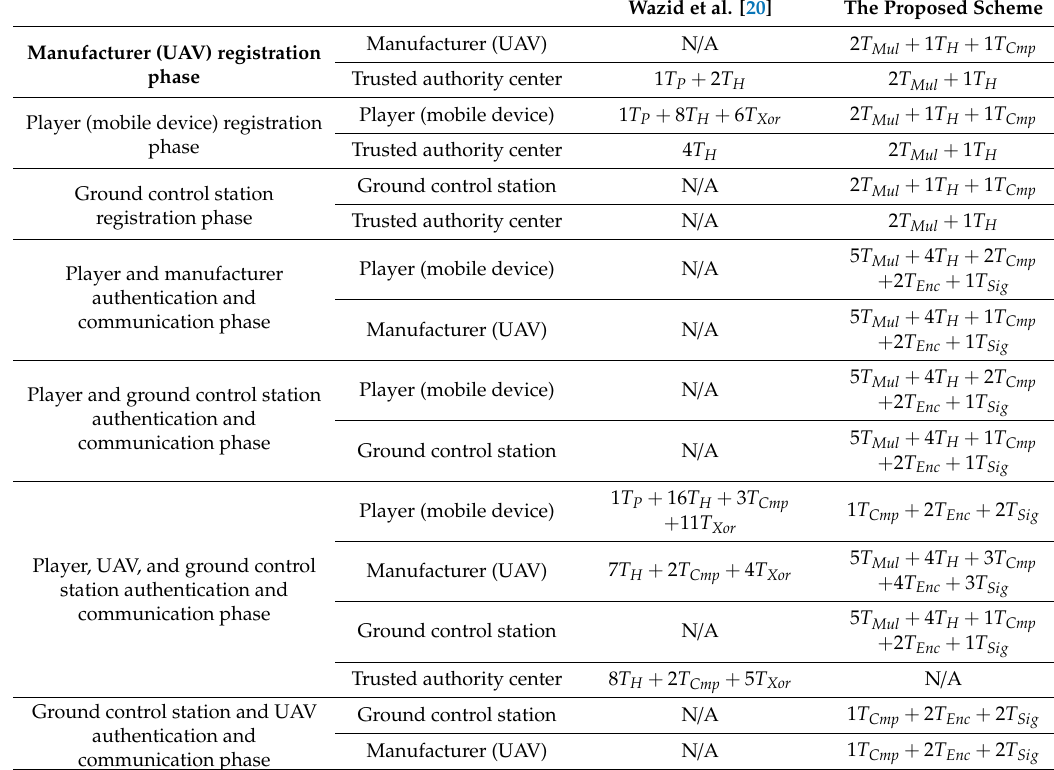
Table 3. Computation cost of the proposed scheme and Wazid et al.’s scheme